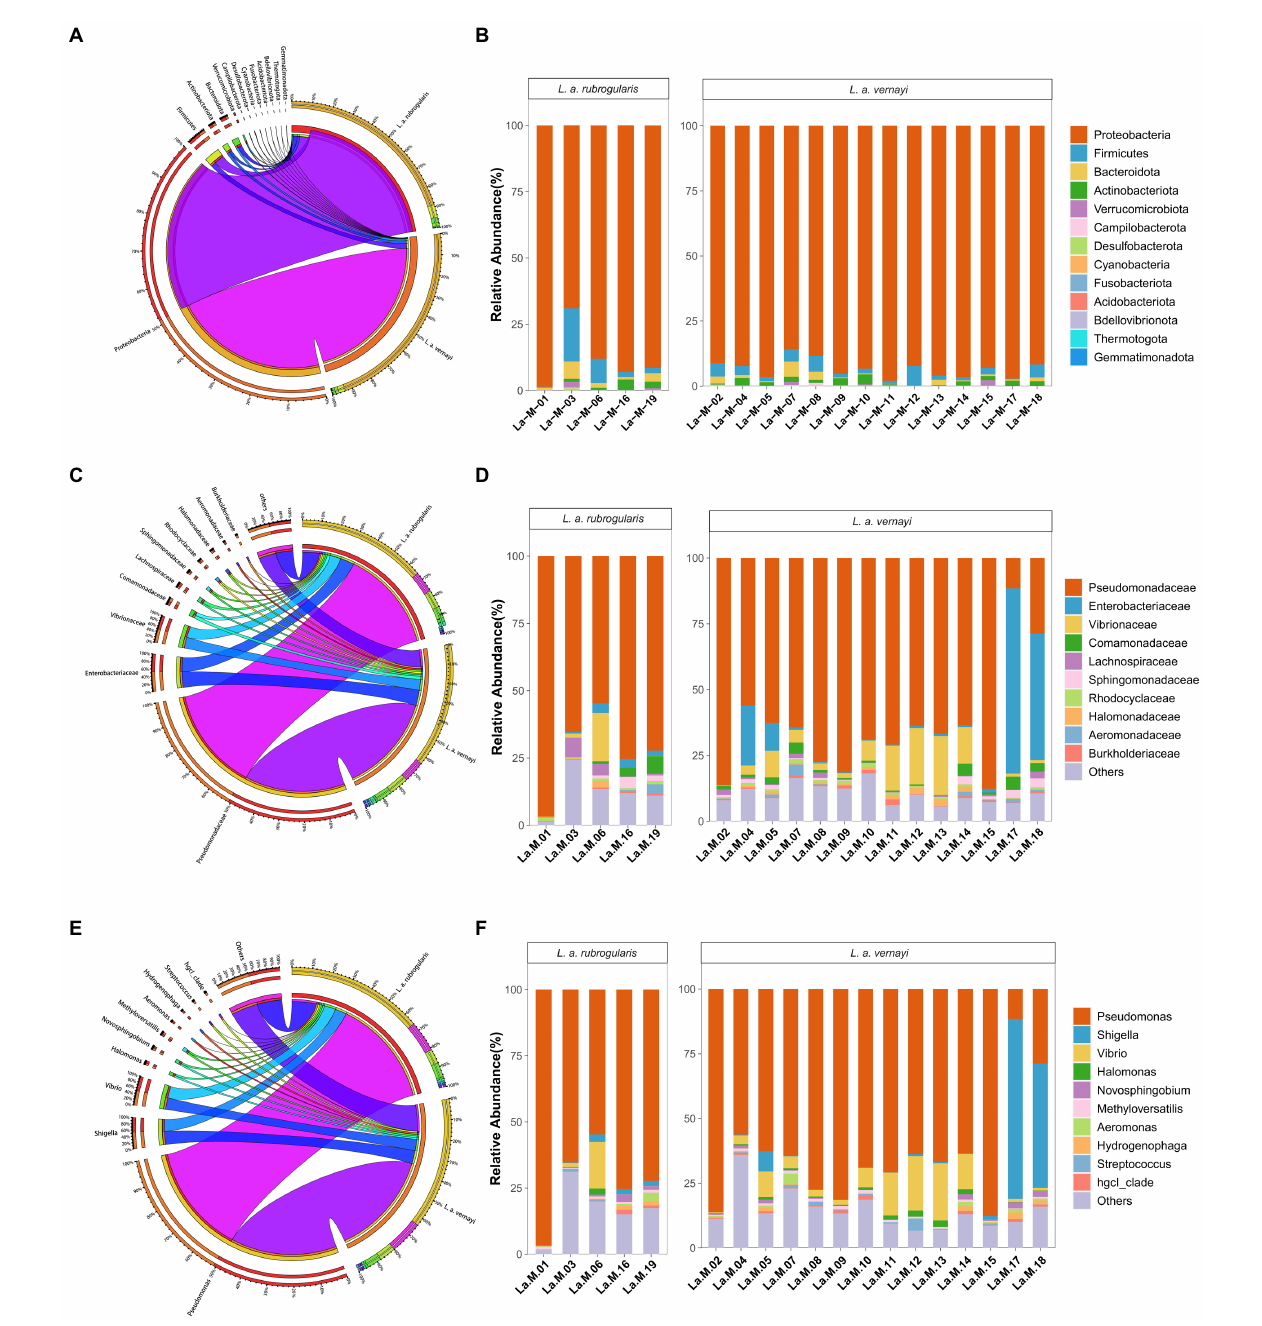
FIGURE 4 Relative abundance of the dominant taxa in the L. a. rubrogularis and L. a. vernayi . (A) Phylum; (C) family; (E) genus. Relative contribution of the dominant taxa in all samples. (B) Phylum; (D) family; (F)